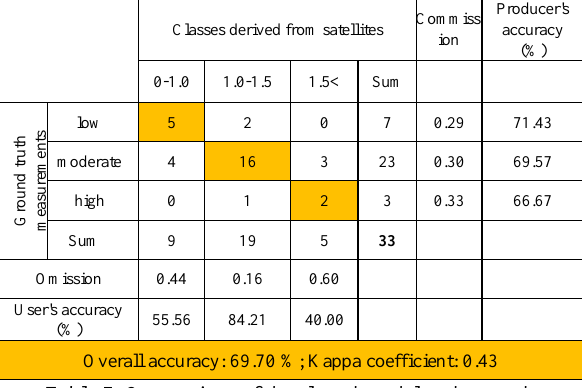
Table 7. Comparison of developed model and ground